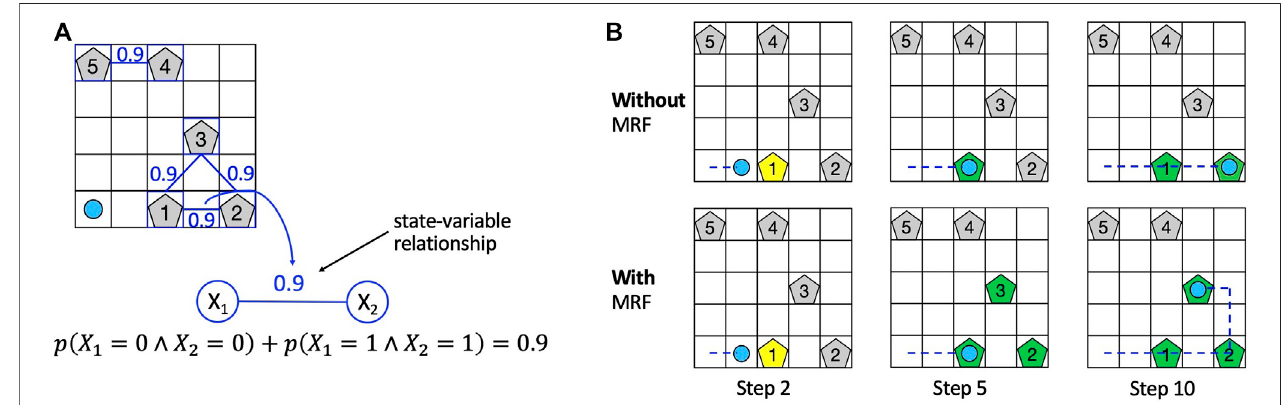
FIGURE 1 | (A) Example of usage of the MRF in the rocksample environment. The MRF topology is depicted using rocks as nodes, and equality probability constraints are speci fi ed on blue edges between rocks. (B) Effect of the action performed by the agent at steps 2, 5, and 10 using standard POMCP ( fi rst row) and the information stored in the MRF (second row). A yellow-colored rock means that the rock is checked by the agent, whereas a green-colored rock represents a rock observed to be valuable by the agent. We consider rocks 1, 2, and 3 valuable in this example.